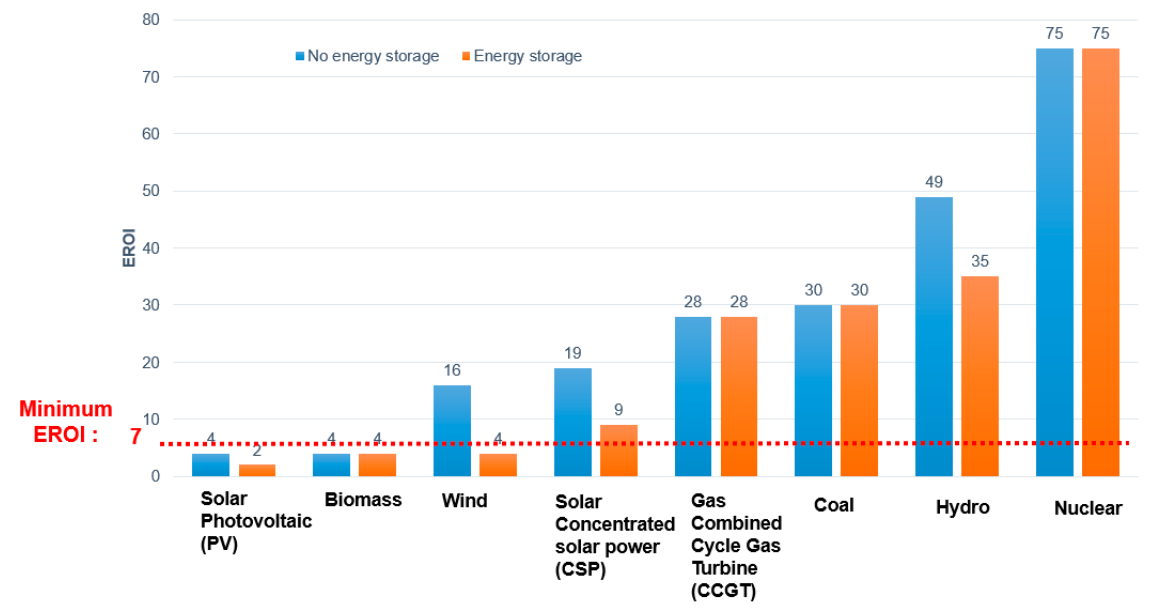
Figure 7. EROI of different fuels, data adapted from Weißbach et al. [27]. The minimum EROI is taken as the average minimum EROI value from Hall et al. [28].